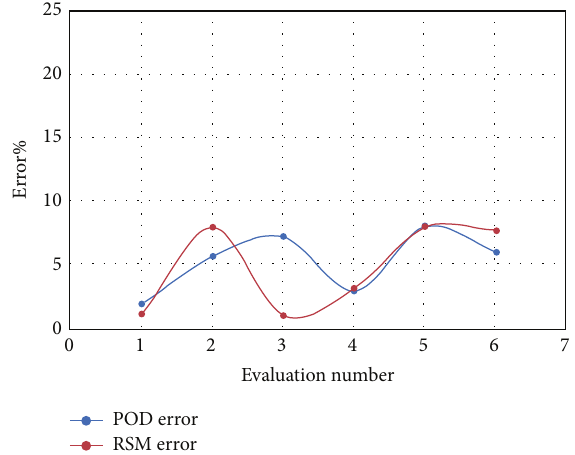
Figure 15: Comparison between RSM and POD method. Recon- struction of the lift coefficient 𝐶 𝑙 .